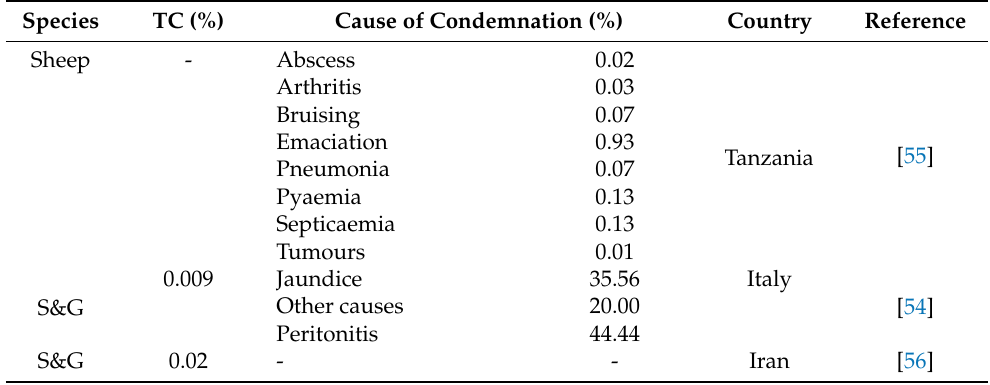
Table 4. Small ruminant causes of carcass